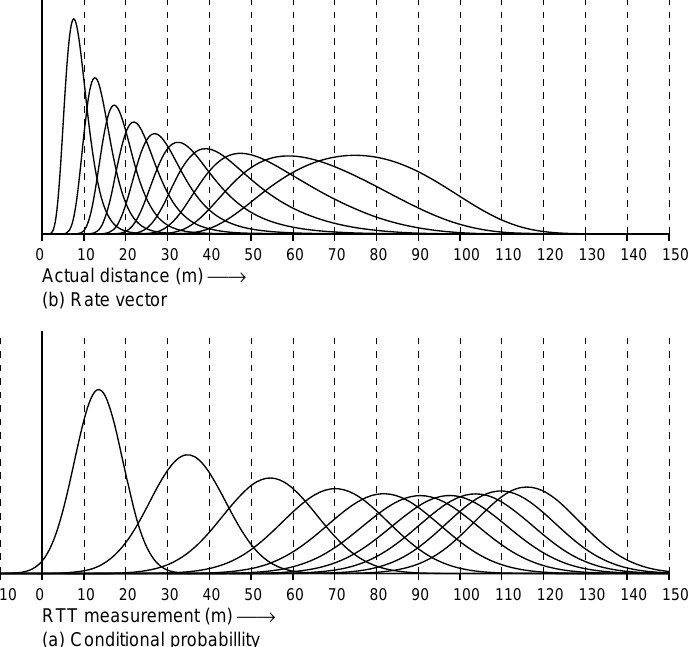
Figure 6. Fitted observation model. ( a ) Conditional probability plotted versus RTT measurement. The curves are for (left to right) actual distances of 10 m, 20 m, ..., 100 m. ( b ) Rate vectors plotted versus actual distance. The curves are for (left to right) RTT measurements of 10 m, 20 m, ..., 100